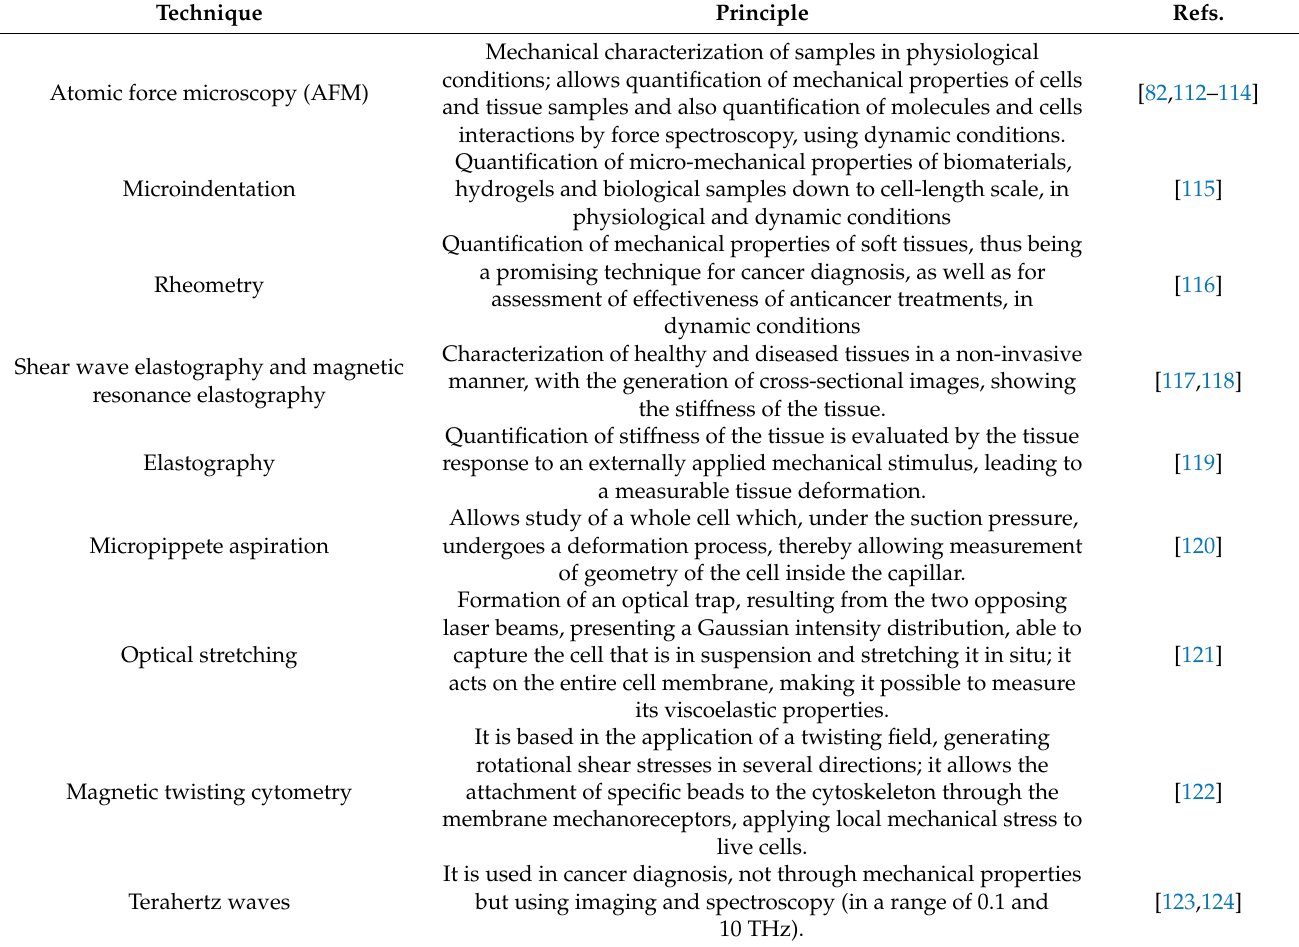
Table 1. Characterization techniques to study the mechanobiology and